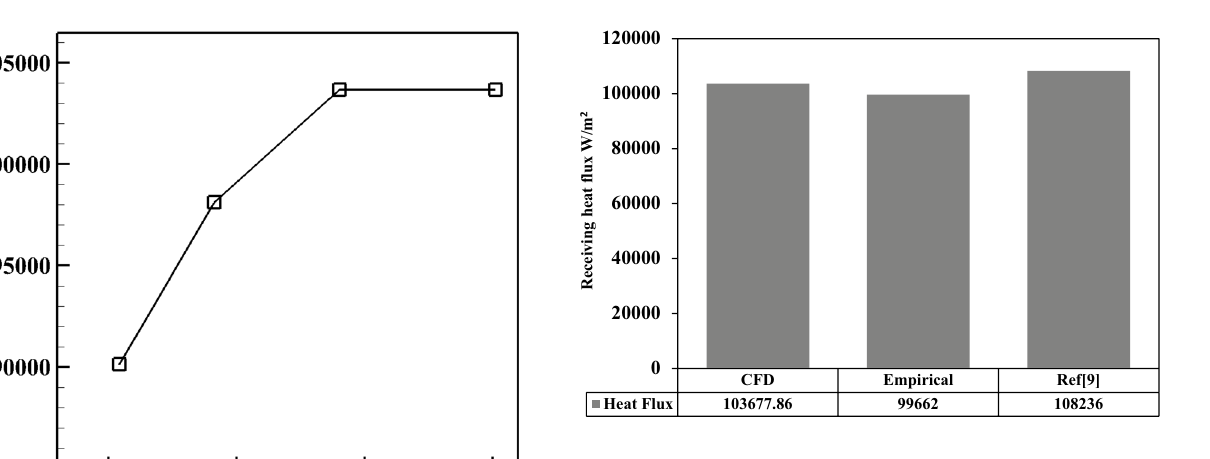
Fig. 10 Comparative receiving heat flux recent; CFD relative to Empirical and Ref